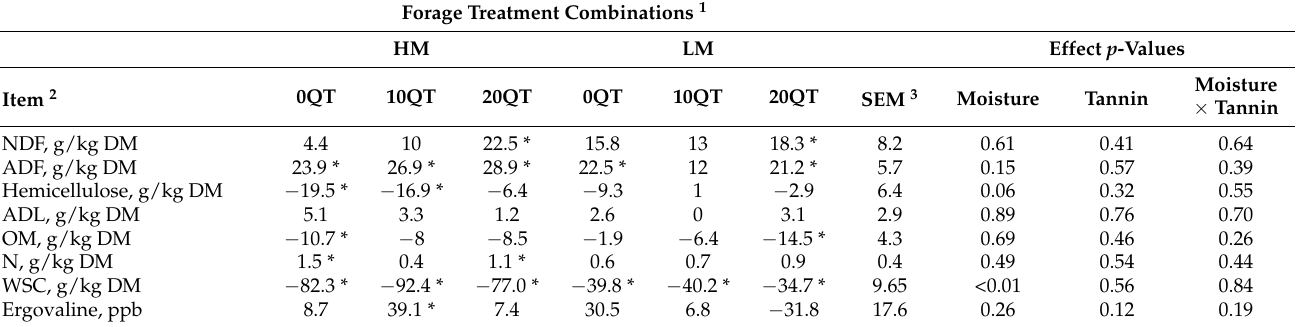
Table 2. Changes in forage chemical components between pre-ensiling and post-ensiling for tall fescue ensiled in laboratory silos at different moistures without quebracho tannin (QT) or with tannin at 10 (10QT) or 20 (20QT) g/kg total silage